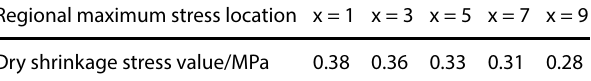
Table 3 Values of dry shrinkage stress in each region of Semi-rigid type base Regional maximum stress location x = 1 x = 3 x = 5 x = 7 x =